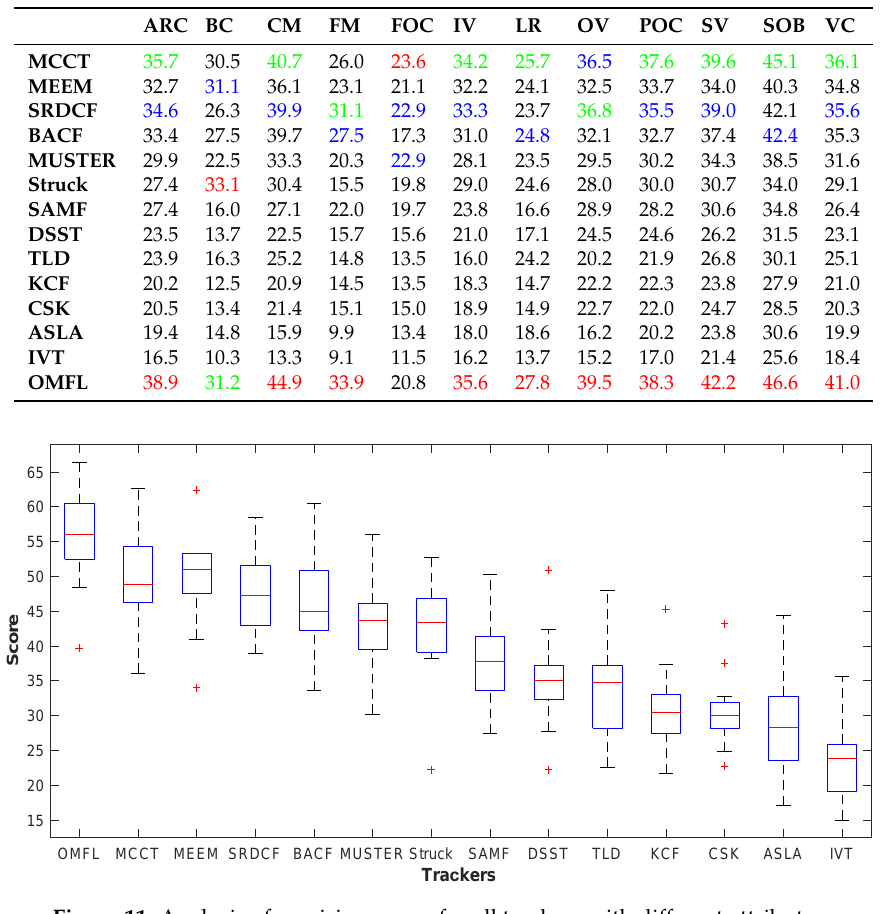
Figure 11. Analysis of precision socres for all trackers with different